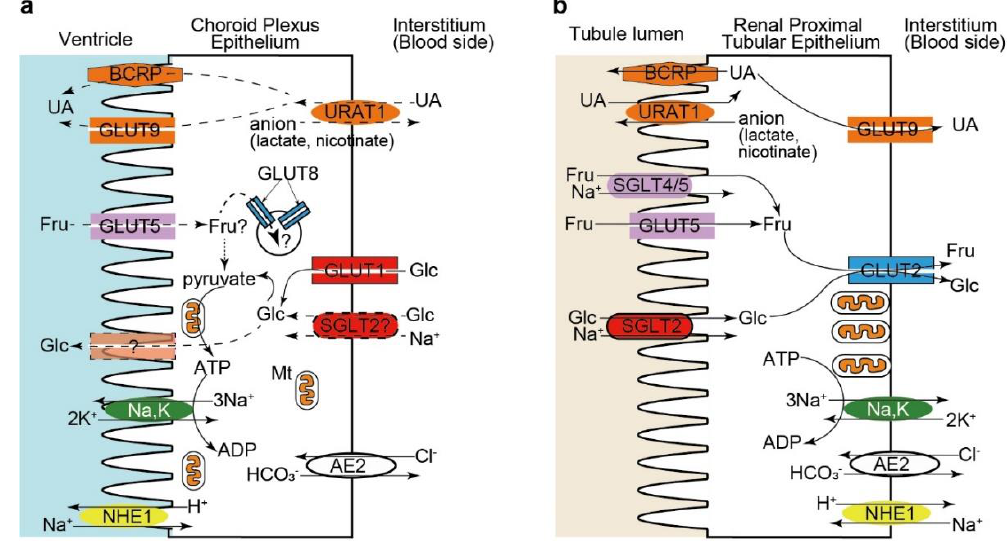
Figure 5. Polarized distribution of glucose (Glc), fructose (Fru), and urate (UA) transporters in choroid plexus (CP) epithelial cells ( a ) and renal proximal tubular epithelial cells ( b ). Putative directions of Glc, Fru, and UA transport through CP epithelial cells are indicated by dashed arrows. The transporter for Glc in the apical side of CP epithelial cells in mammals is still uncertain (indicated by a semitransparent rectangle labeled with a question mark). GLUT8 is expressed in the intracellular membranes, such as lysosomes, endoplasmic reticulum, and endosomes. As examples for the partially inverted distribution of transporters between CP epithelial cells and renal proximal tubular epithelial cells, the localization of Na + ,K + -ATPase (Na and K) and NHE1 is indicated. AE2 is located in the basolateral membrane in both cells. Mt,